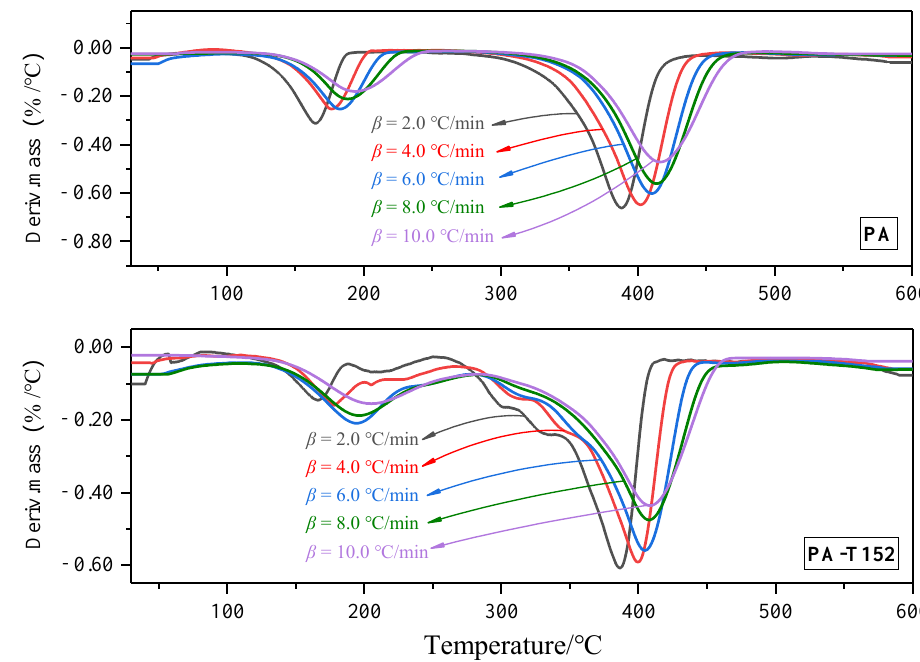
Figure 4. DTG curves of PA and PA-T152 at different β .